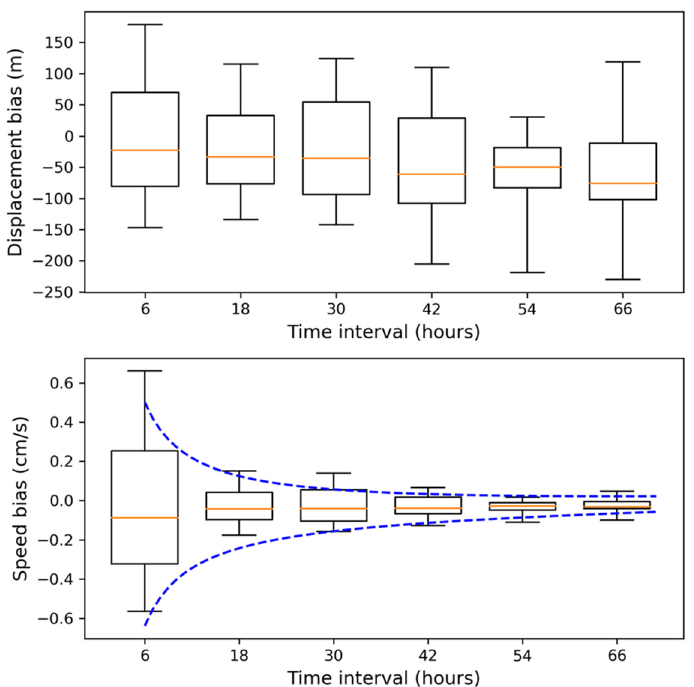
Figure 8. Bar plot of bias in estimated drift displacement, speed and the time interval of pair images, sampled in every 12-h bins. Blue dotted lines are the best fit models.